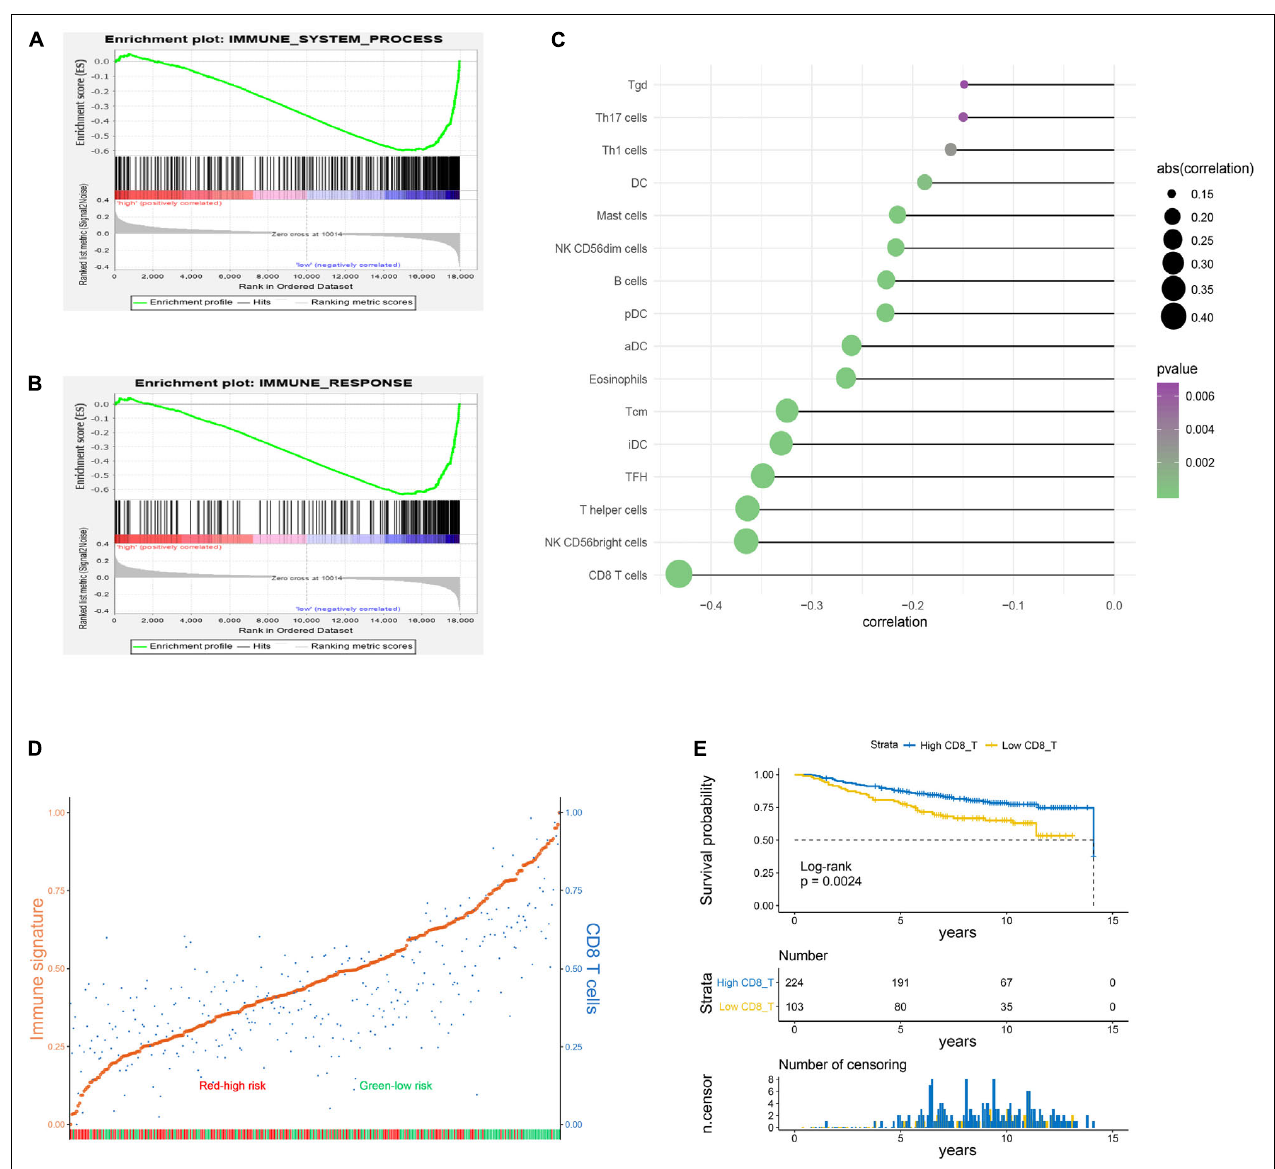
FIGURE 5 | Immune status analysis for high– and low–risk groups. (A,B) Gene set enrichment analysis (GSEA) indicated a significant enrichment of immune–related phenotype in the low–risk group. (C) Pearson correlation analysis between risk scores of the six-lncRNA signature and enrichment scores of the immune cells. The results with p -value < 0.05 were extracted. (D) Enrichment scores of immune signature and CD8 T cells in high- and low-risk cohorts. The patients were divided into two subgroups on the basis of the median risk score. The enrichment score was scaled to be between 0 and 1 in the plot. Orange: immune signature; blue: CD8 T cells; red: high-risk patients; green: low-risk patients. (E) Kaplan–Meier curve associated with CD8 T